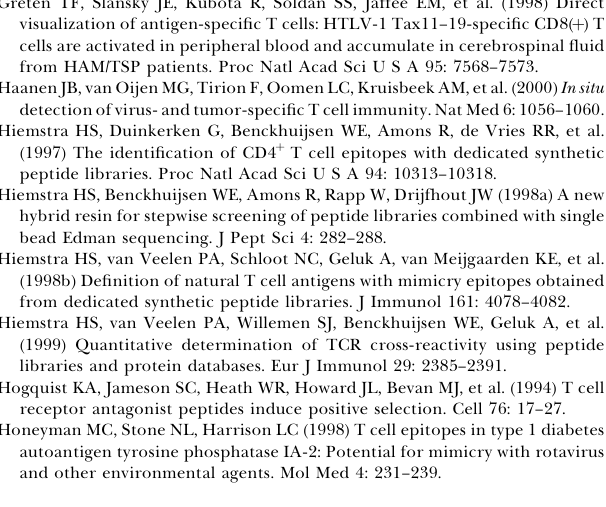
Figure S1. Binding of OT-1 Lymphocytes to a Serial Dilution of OVA/ K b Tetramer The effect of tetramer dilution on cell capture was tested by examining the binding of OT-1 lymphocytes to a serial dilution of immobilized OVA/MHC tetramer. The cells were suspended at a concentration of 2.5 3 10 6 /ml and incubated on the array for 30 min at room temperature. Following the removal of unbound cells, the array was imaged and scored for the number of OT-1 cells on each of the spots. (A) A reconstruction of the relevant array region by a patchwork of 10 3 images, revealing a monotonic reduction in the number of bound cells with tetramer dilution. Amount of MHC tetramer deposited is given in nanograms per spot. (B) In this specific example, the number of immobilized OT-1 lymphocytes on the OVA/K b spots was linearly dependent on the amount of tetramer deposited. Averaged cell numbers and standard errors are based on triplicate spots. The line represents a linear fit to the data.